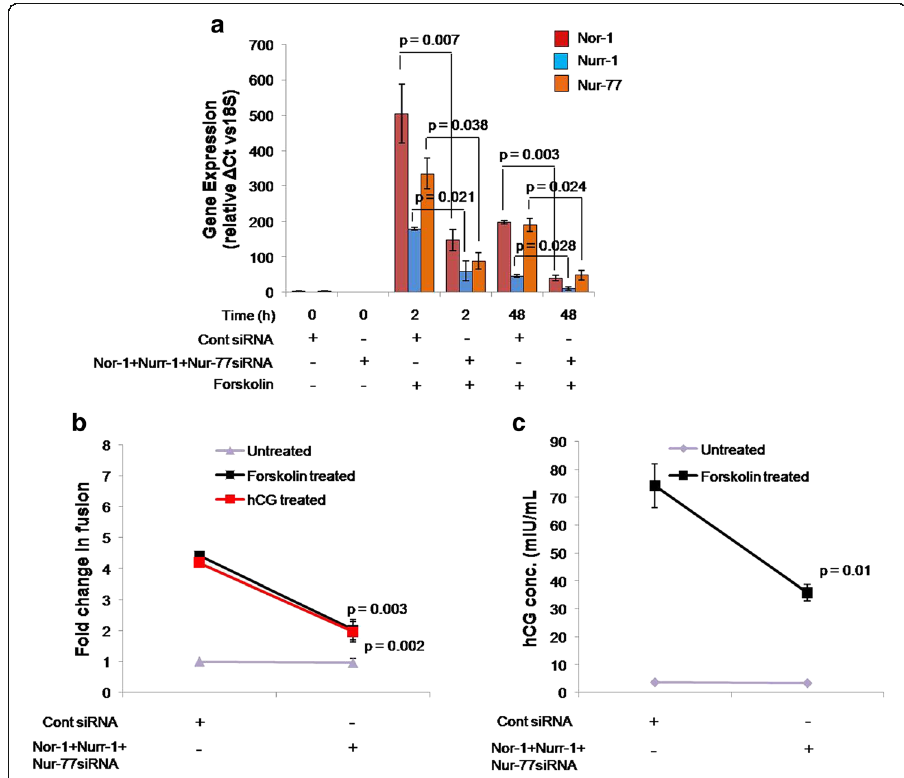
Fig. 5 Effect of simultaneous silencing of Nor-1, Nurr-1 and Nur-77 on forskolin- or hCG-mediated BeWo cell differentiation. BeWo cells were knocked down for Nor-1, Nurr-1 and Nur-77 simultaneously using siRNA as described in Methods section. To confirm target-specific silencing of all three nuclear orphan receptors, qRT-PCR was performed at 0, 2 and 48 h after forskolin treatment in control siRNA-transfected and silenced cells. The effect of NR4A silencing on BeWo cell fusion and/or hCG secretion was studied after 48 h of for- skolin and hCG treatment. a – Comparison of the transcript levels of Nor-1, Nurr-1 and Nur-77 in the control siRNA-transfected and NR4A-silenced cells. Each bar represents relative expression after normalization with 18S rRNA, expressed as means ± s.e.m. of three independent experiments performed in triplicate. b – The fold change in forskolin-mediated BeWo cell fusion in control siRNA-transfected cells and NR4A-silenced cells. Values are shown as means ± s.e.m. of three independent experiments. c – hCG secreted by control and NR4A-silenced cells on treatment with forskolin for 48 h. Data are represented as means ± s.e.m. of three independent experiments performed in duplicate. p ≤ 0.05 is considered statistically